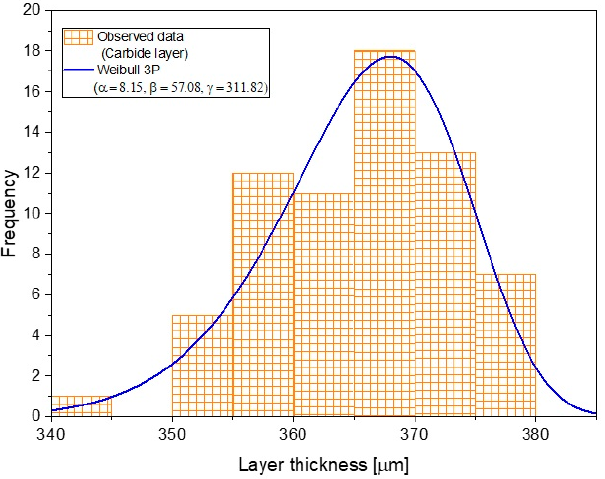
Figure 13. Carbide layer thickness histogram fitted to Weibull 3P. Table 10. Thickness layer observations fitted to probability density functions.